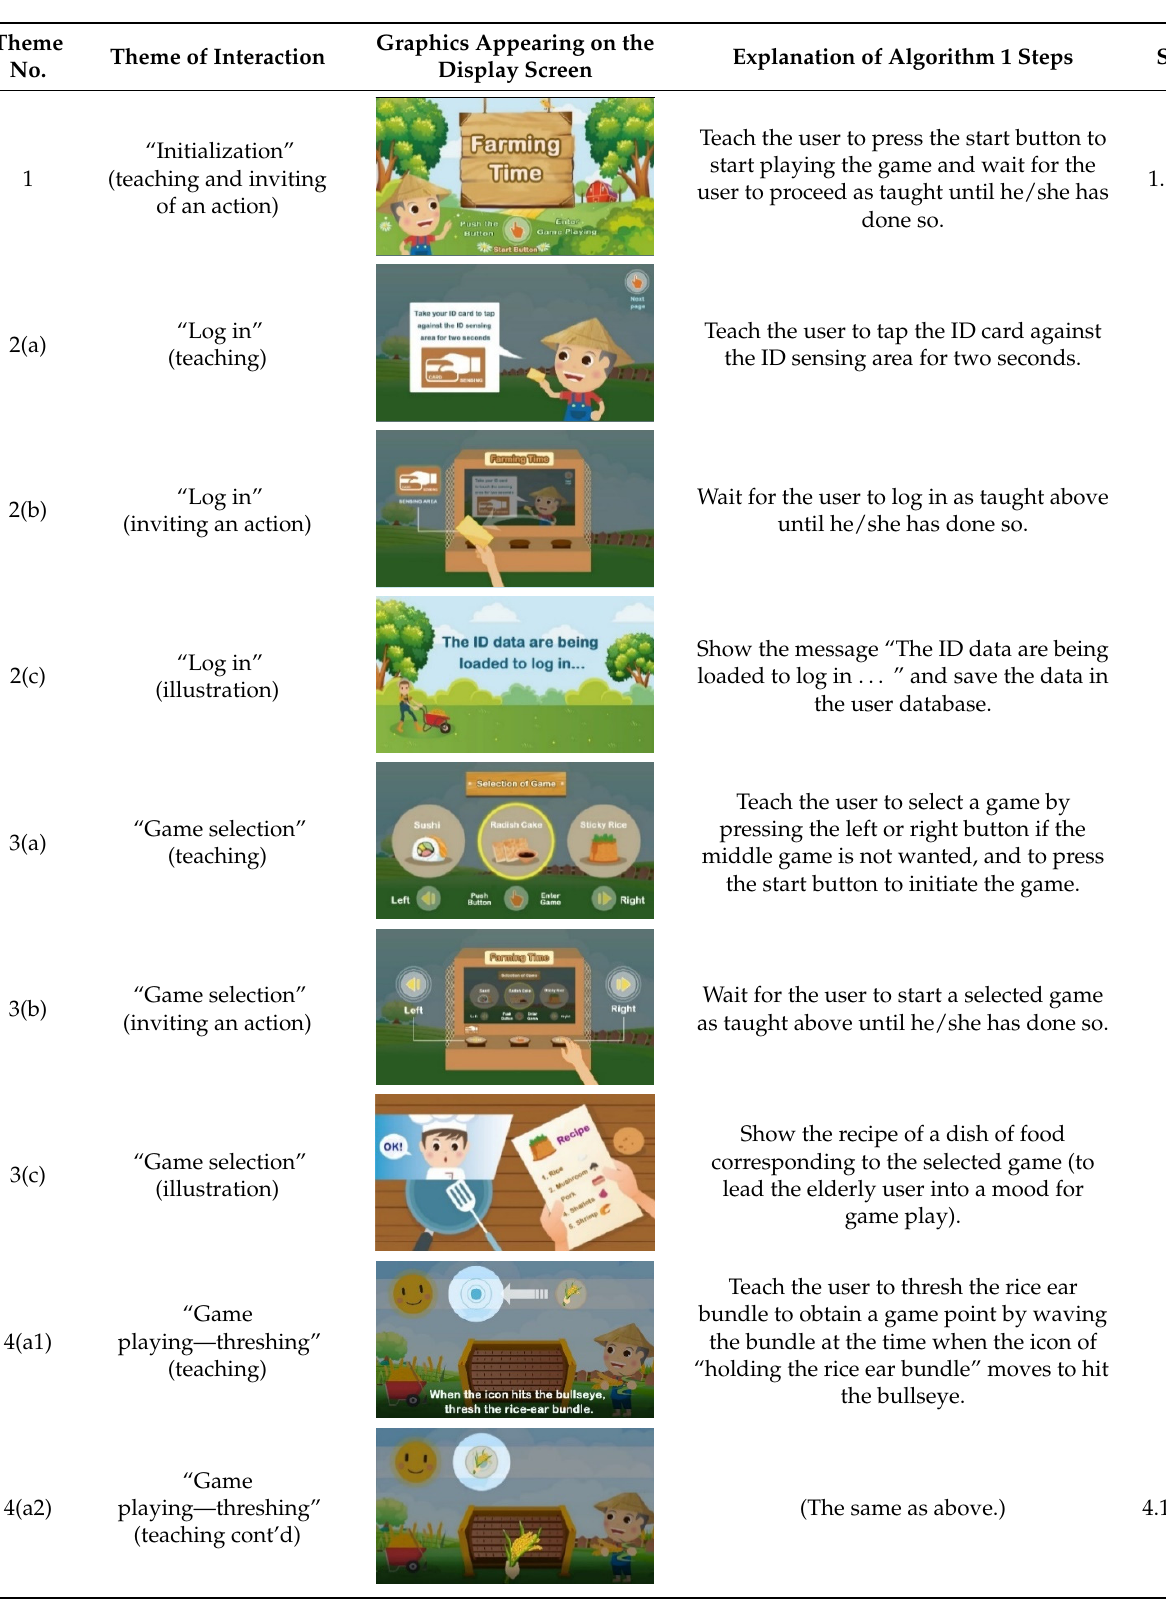
Figure 5. Architecture of the proposed interactive system “Farming Time.”.